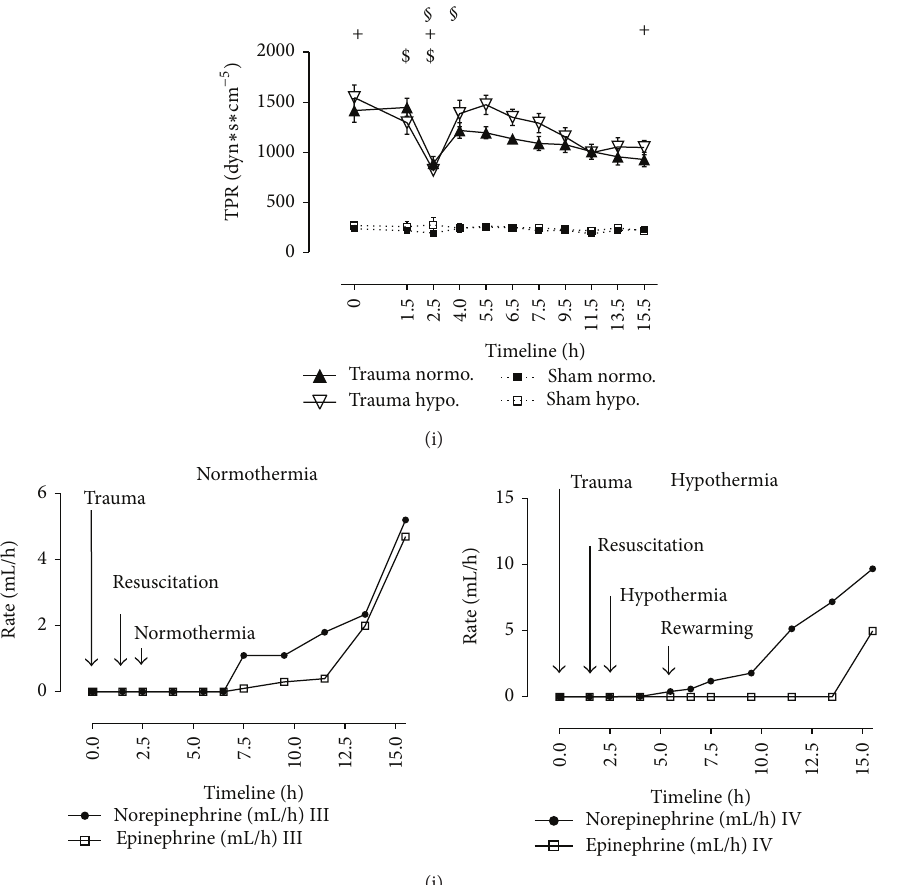
Figure 2: Normothermic and hypothermic sham animals versus normothermic and hypothermic trauma animals. 𝑁 = 40 . Timeline 15.5 hrs. Data are shown in mean and standard error of mean. + 𝑃 < 0.05 , values at BL versus values at S and at R and values at E of trauma pigs (0, 1.5, 2.5, and 15.5 hrs). ∗ 𝑃 < 0.05 , normothermic versus hypothermic pigs during cooling phase (4, 5.5 hrs). $ 𝑃 < 0.05 , values at S versus values at R in trauma pigs (1.5 and 2.5 hrs). § 𝑃 < 0.05 , values at R versus values at H in trauma pigs (2.5 and 4.0 hrs). (a) Heart rate (HR in 1/min). (b) Mean arterial pressure (MAP in mmHg). (c) Central venous pressure (CVP in mmHg). (d) Cardiac output (CO in l/min). (e) Mixed venous oxygen saturation (SvO 2 in %). (f) Stroke volume (SV in mL). (g) Pulmonary artery pressure (PAP in mmHg). (h) Wedge pressure (WP in mmHg). (i) TPR (dyn ∗ sec ∗ cm −5 ). (j) Norepinephrine and epinephrine in 3 mg/50 mL (in